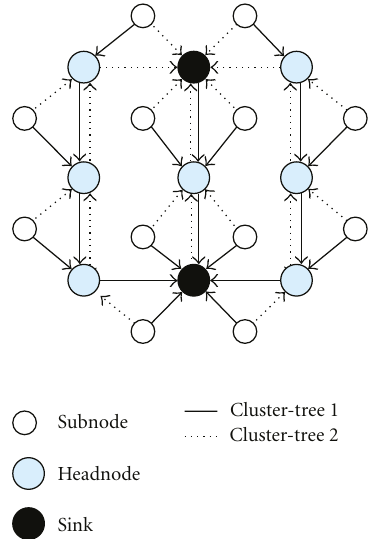
Figure 6: Multi-cluster-tree network topology ( k =